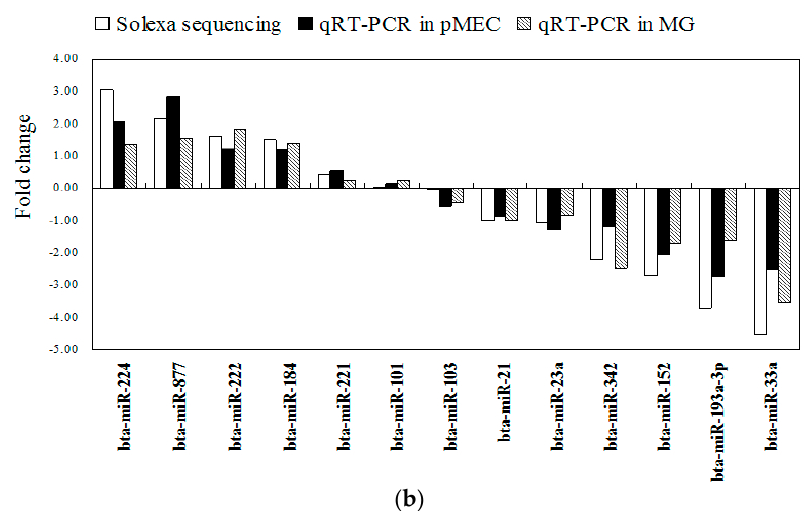
Figure 2. Validation of known miRNAs using stem-loop qPCR. ( a ) 13 known miRNAs were detected by stem-loop qPCR, using three replicates. The relative expression was calculated using the 2 −ΔΔ C t method after the threshold cycle ( C t ) and was normalized using the C t of U6. The relative expression levels were presented as the 2 −ΔΔ C t means ± standard error. The error bars indicate the standard error of the 2 −ΔΔ C t mean values. *: 0.01 < p < 0.05, **: p < 0.01; ( b ) Comparison of expression patterns for known miRNAs (identified by Solexa sequencing) between pMECs and mammary gland (MG) tissues. X -axis: the miRNA types; Y -axis: expression differences of miRNAs in high and low fat samples. Because the methods used to calculate differential expression by stem-loop qPCR differs from that used by Solexa sequencing, significance analysis was not performed, and the figure only shows the general trend of miRNA expression.